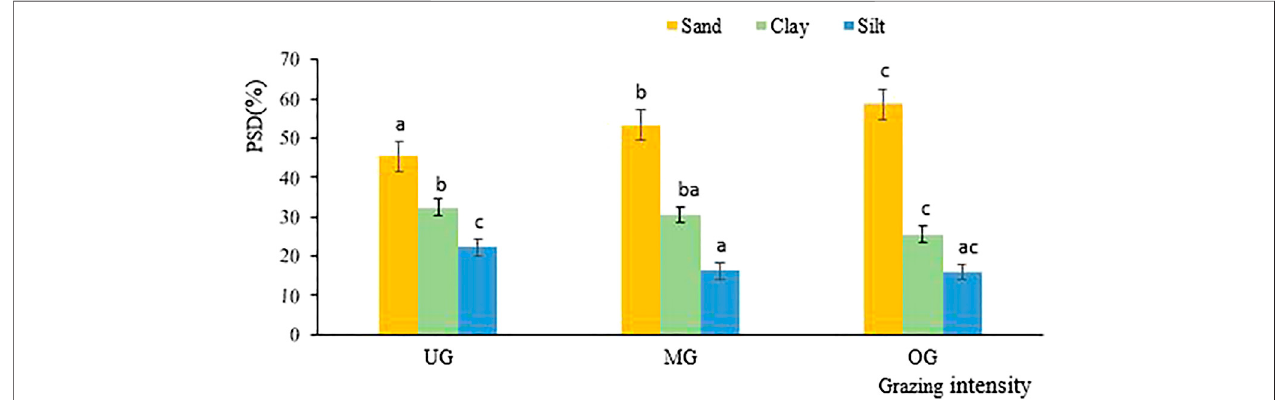
FIGURE 3 | Mean ± SE particle size distribution across grazing intensity. Bars with different letters are signi fi cantly different for each grazing intensity site, PSD, particle size distribution; NG, non-grazing; MG, moderately grazing; OG, overgrazing.